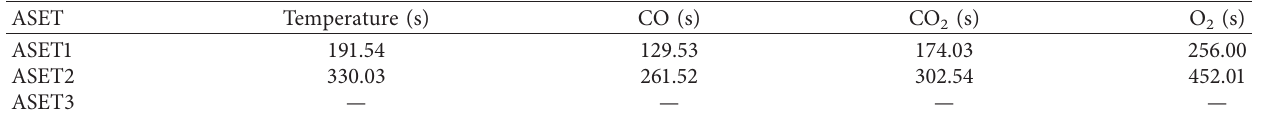
Table 12: Available safe egress